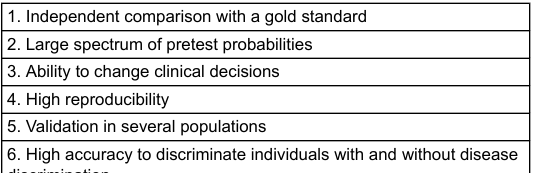
Table 5: Criteria for additional screening test quality (adapted from [58]). 1. Independent comparison with a gold